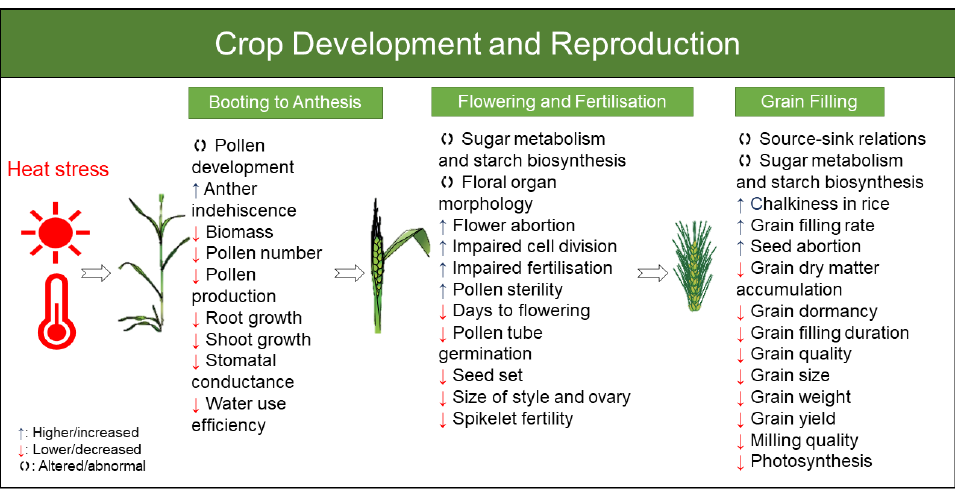
Figure 2. Adverse effects of heat stress on the different stages of the reproductive phase in cereal crop plants.